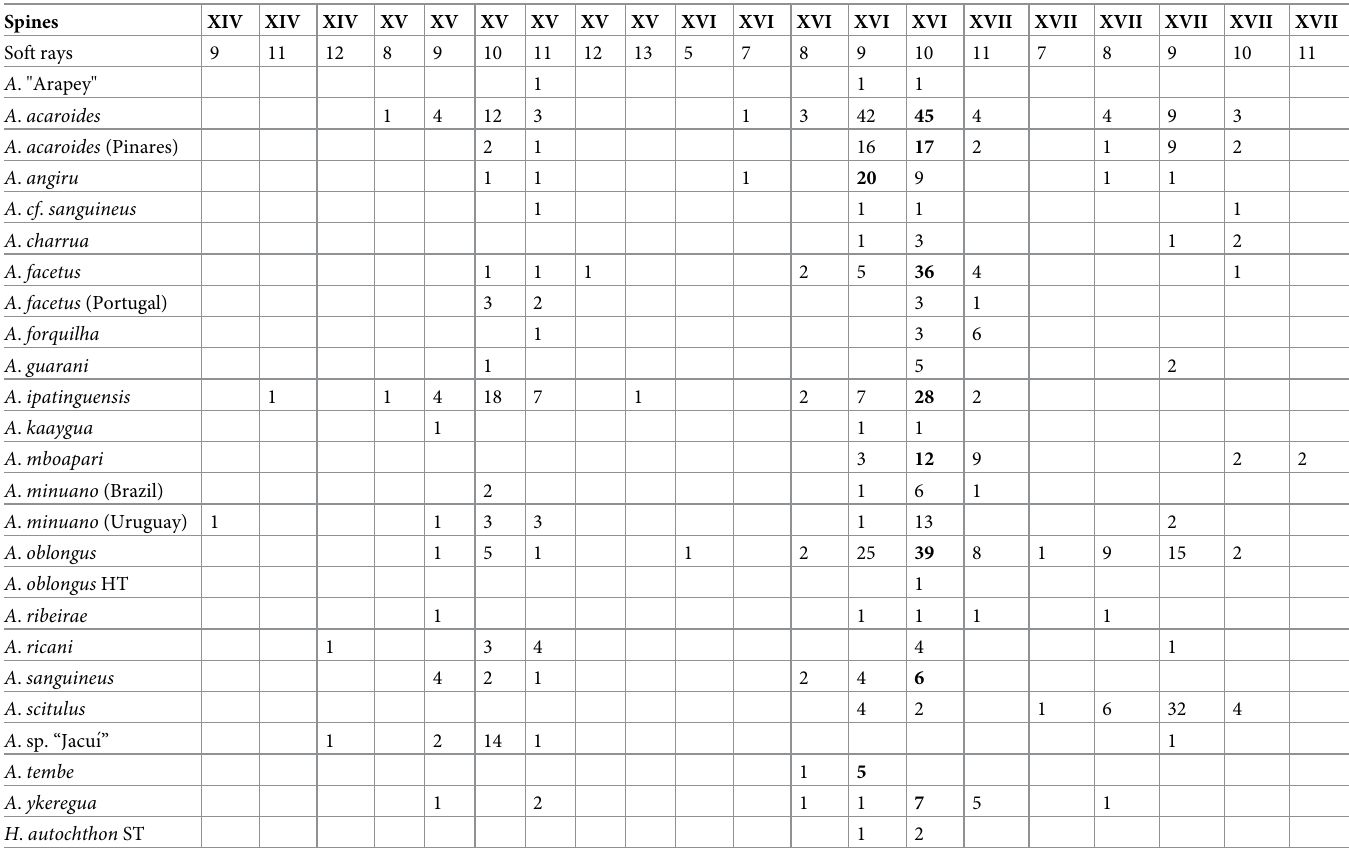
Table 6. Number of dorsal-fin rays in species of Australoheros